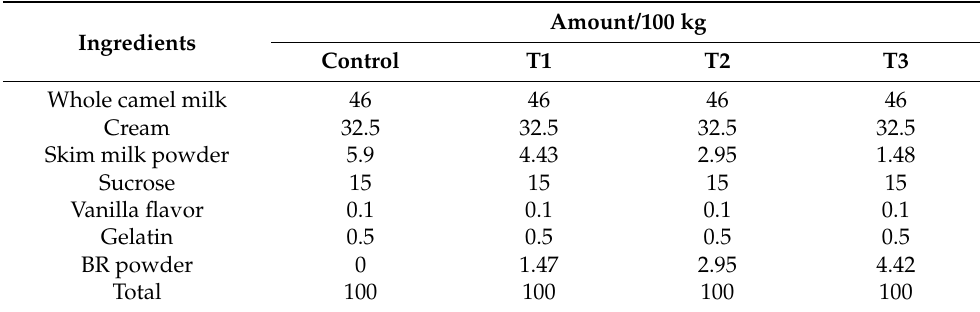
Table 1. Ice-cream-mix